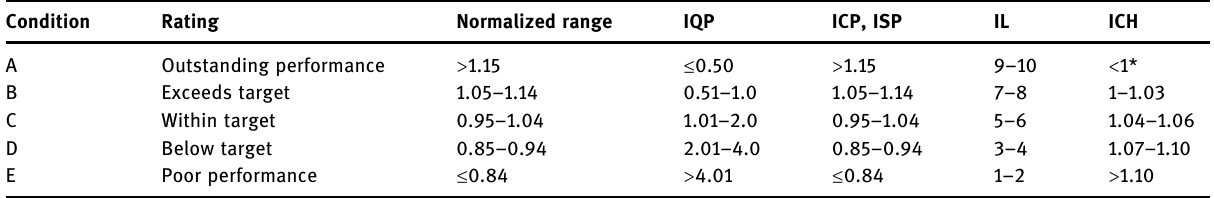
Table 7: Ratings, normalized, and index ranges for the assessment indicators ( adapted from ref. [ 44 ])